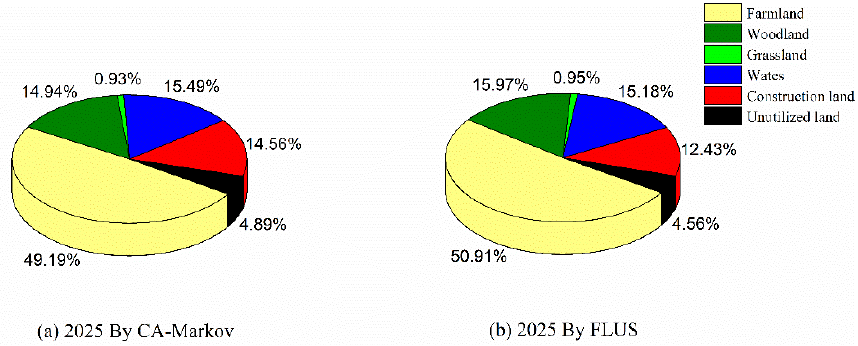
Figure 8. Percentage of each land ‐ use type in 2025 projected by CA ‐ Markov and FLUS.